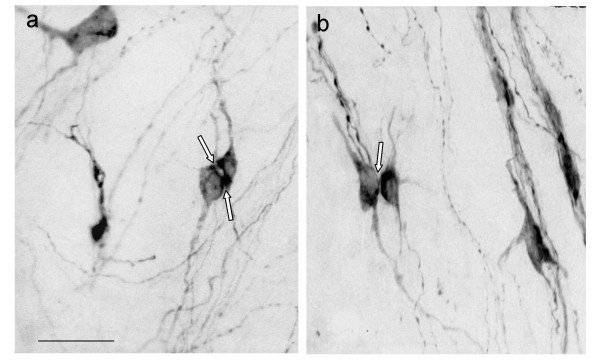
GnRH-immunoreactive neurons in the preoptic area of ewes. a and b represent two examples of clusters of GnRH-immunoractive neurons, white arrows indicate putative contacts between the neurons. Scale bar: a, b – 40 μm